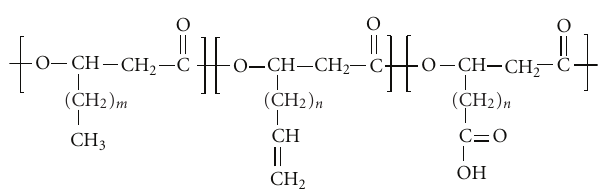
Figure 4: PHOU with pendant carboxylic acids (PHOU-COOH). quantitative conversions of the unsaturated groups into epoxy groups [40]. Primary and secondary amines can be reacted with epoxide groups to yield hydrophilic com- pounds. Reaction between hexamethylene diamine with epoxidized PHOU provides cross-linked polyester [41].